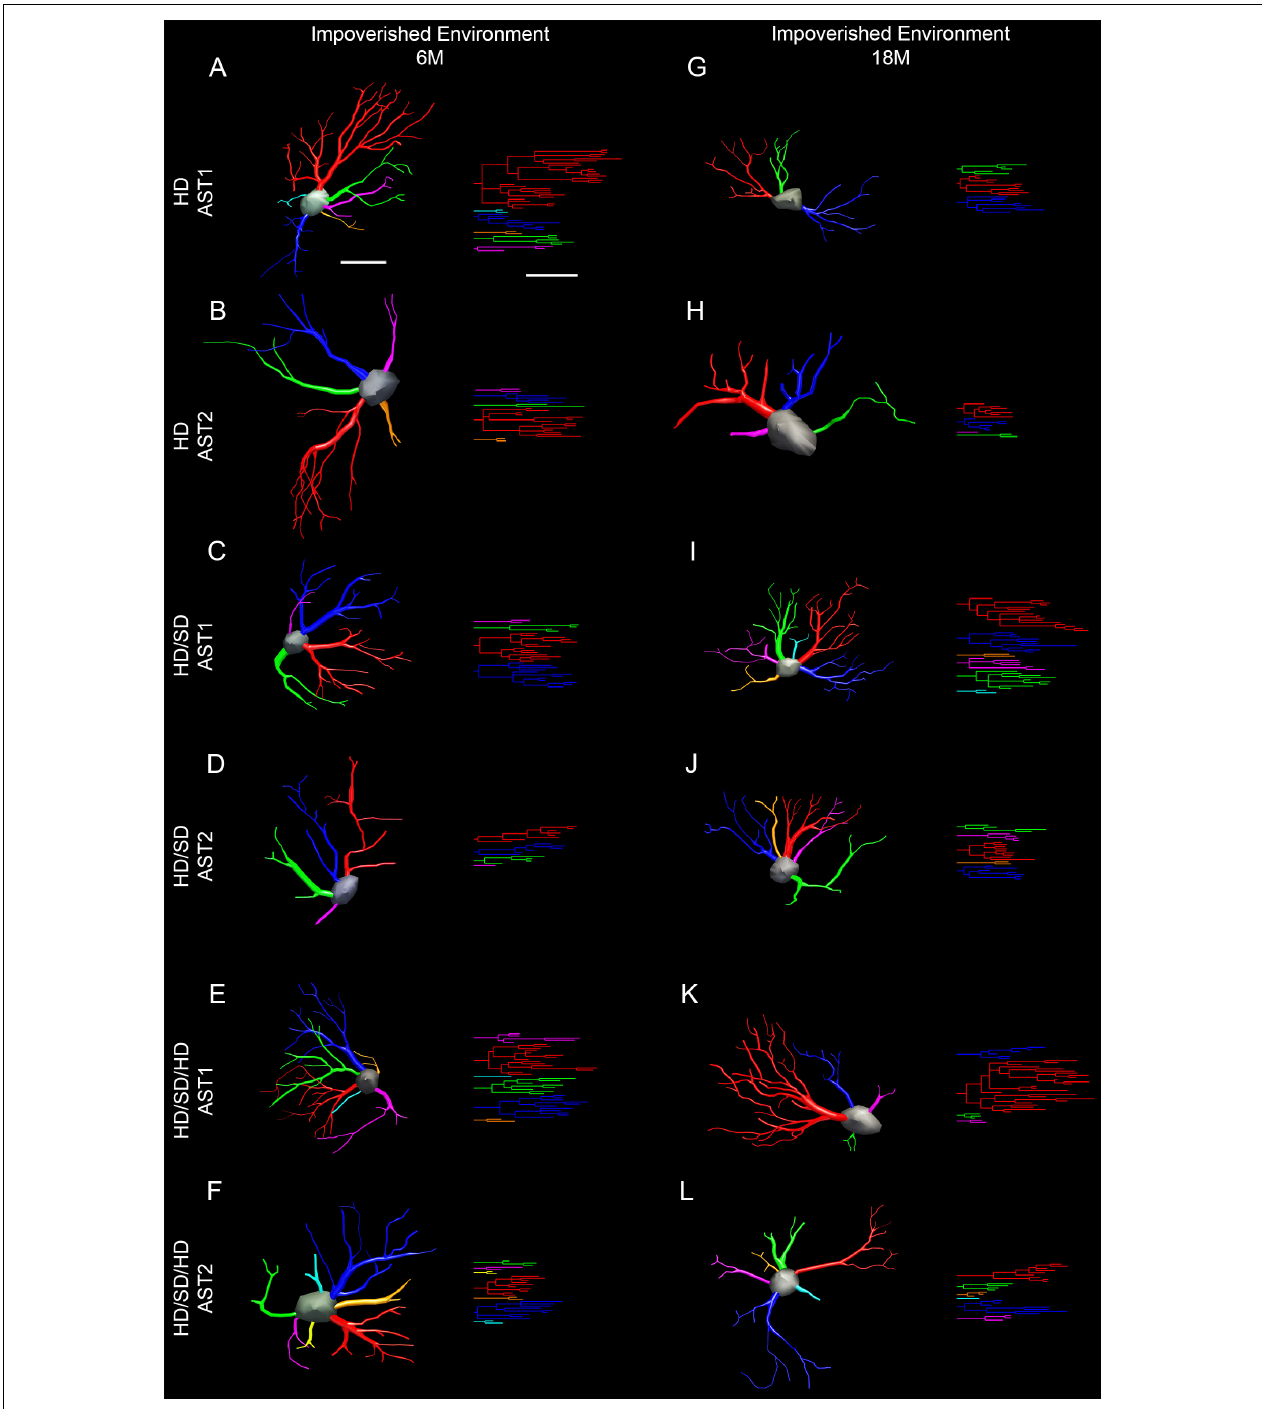
FIGURE 6 | Three-dimensional reconstruction of the morphological phenotypes of astrocytes located in the outer 1/3 of the molecular layer of dentate gyrus, in Mus musculus animals, and respective dendrograms of each astrocytic phenotype per experimental group maintained at impoverished environment, reconstructed and analyzed through the Neuroexplorer software (MicroBrightField). To choose the representative cell of each group, the distance matrix was used to obtain the sum of the distances of each cell in relation to all the others. We considered the cell better representing each group as having at the least the sum of distances. Branches originating from the same parental trunk (primary branch) are shown with the same color. (A–F) 6M; (G–L) 18M. Cell bar = 15 µ m; dendrogram bar = 15 µ m. 6M, 6-month-old; 18M, 18-month-old; HD, hard diet/pellet; SD, soft diet/powder food; AST1, astrocyte with high morphological complexity; AST2, astrocyte with low morphological